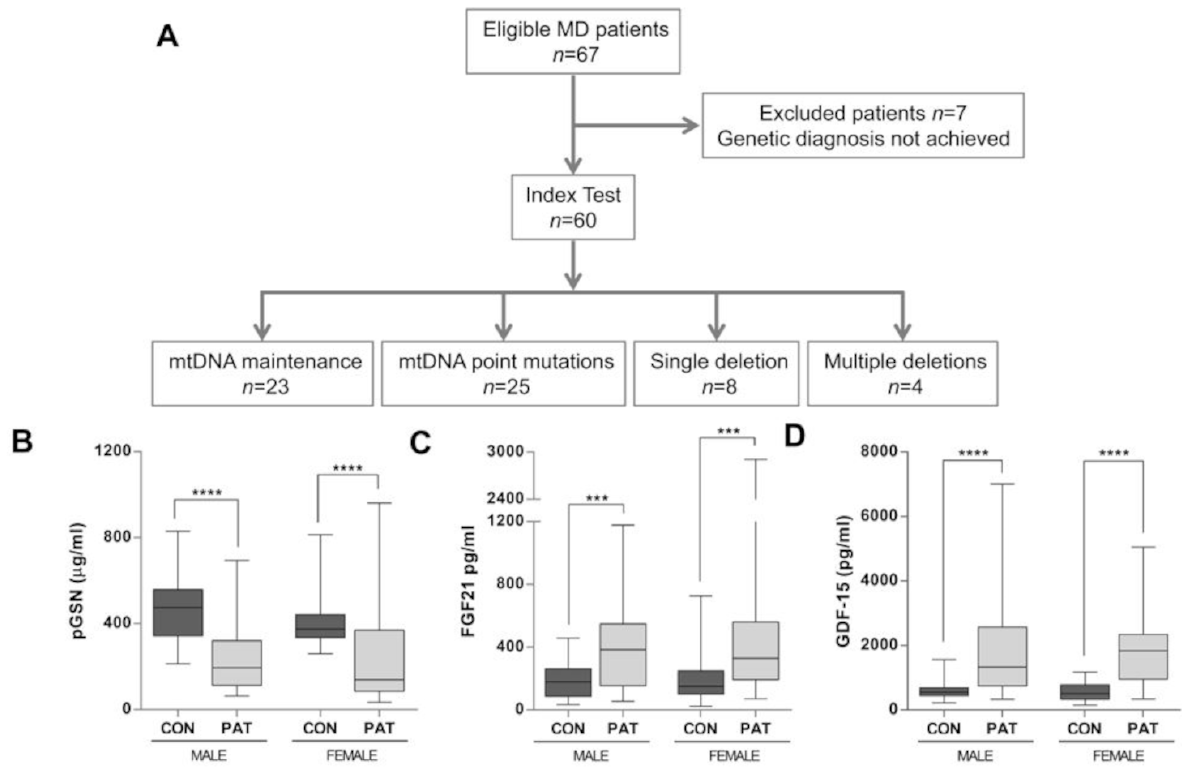
Figure 1. ( A ) STARD flowchart depicting the selection process of the patients with mitochondrial OXPHOS disease (MD). A total of 60 MD patients who fulfilled the genetic and clinical diagnostics criteria were enrolled in this study from 2017 to 2019. mtDNA = mitochondrial DNA. Average concentrations of ( B ) pGSN ( µ g/mL), ( C ) FGF-21 (pg/mL), and ( D ) GDF-15 in healthy controls (CON) vs. MD patients, stratified by sex. CON, healthy cohort; PAT, MD patient cohort. CON: Male ( n = 24), Female ( n = 32); MD: Male ( n = 22), Female ( n = 38). Data are presented as the median, interquartile range, minimum, and maximum. Mann–Whitney U test p values: **** p < 0.00001, *** p <